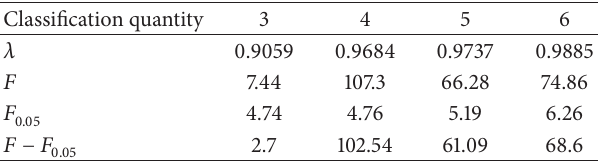
Table 4: 𝐹 -statistics calculation results for each program.